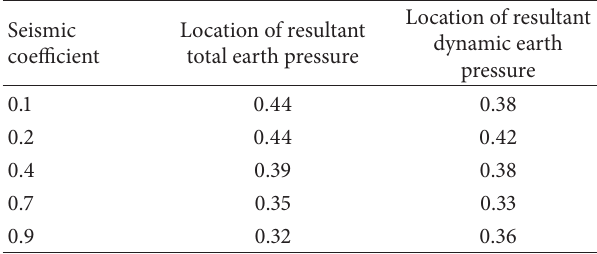
Figure 8: The distribution of dynamic earth pressure.